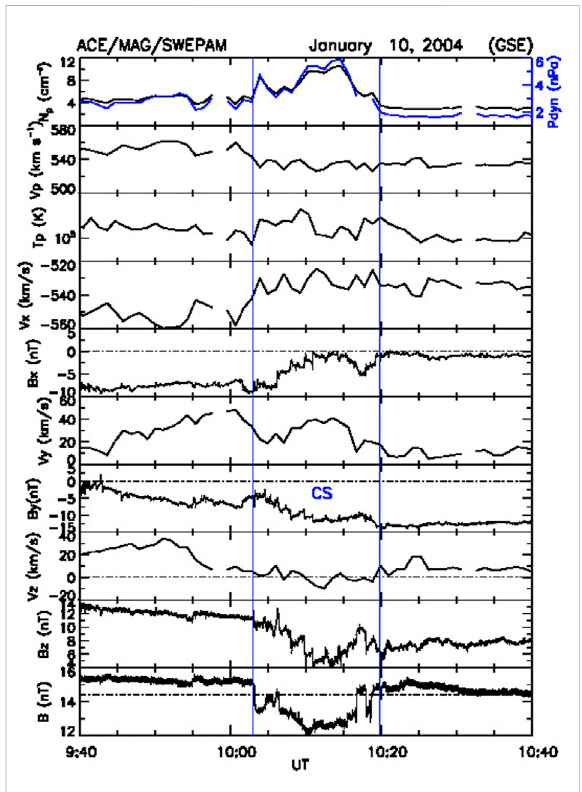
FIGURE 3 A zoom-in of the interval 9:40 – 10:40 UT. The ACE fi eld data arenowataresolutionof1 s.TheverticalbluelinesbrackettheCS. Overlaid on the density in thetop panel is the dynamic pressure (in blue, with scale on the right). Note that the minimum in B (bottom panel) occurs ~5 min before the density reaches its peak